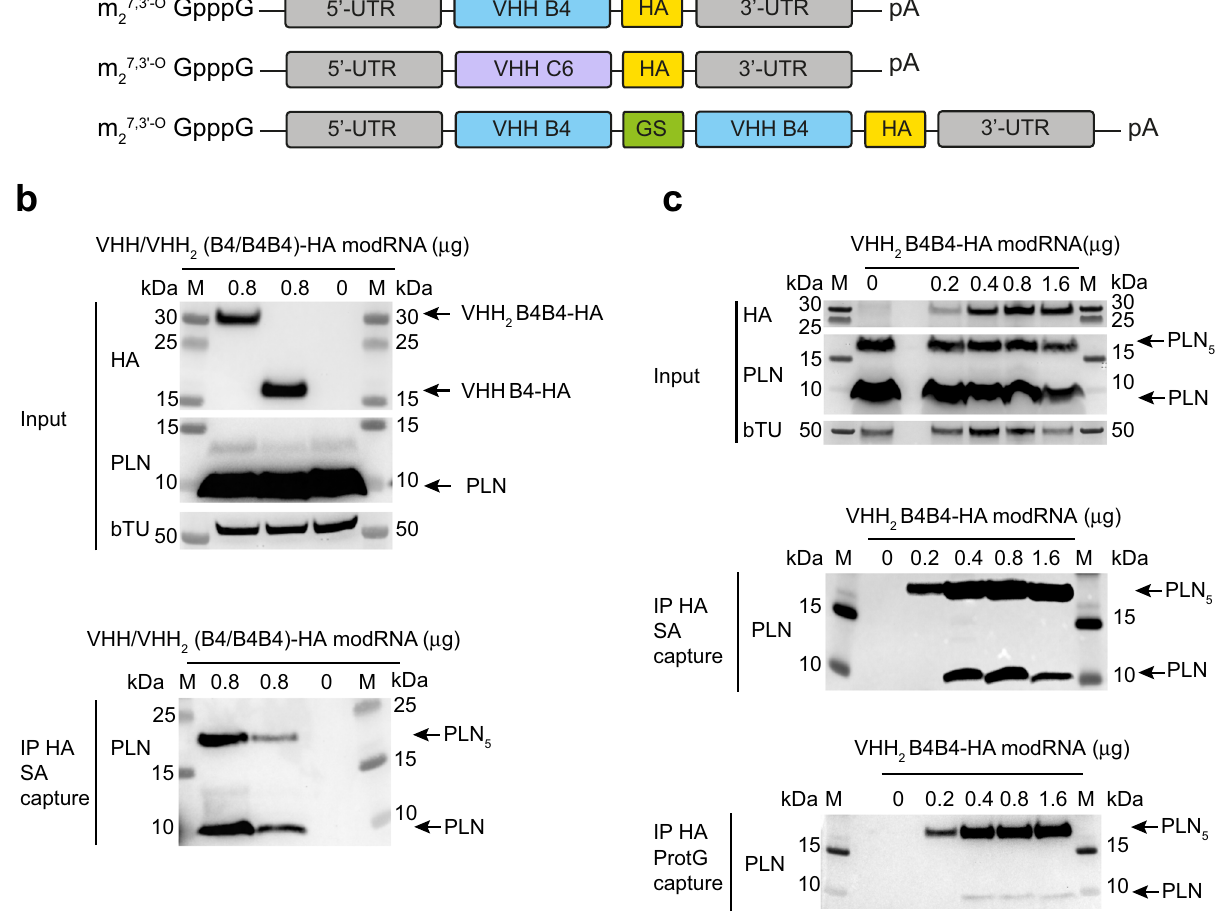
Fig. 2 Endogenous target engagement of intrabodies in rat neonatal cardiomyocytes using modRNA transfection. a modRNA construct design. m 2 7,3'-O GpppG is the ARCA CAP; 3 ’ UTR is the 3 ’ untranslated region, VHH is the intrabody sequence, GS is a sequence that encodes a glycine-serine linker peptide (GGGSGGGSGGGSGGGS), HA is the hemagglutinin tag, 5 ’ UTR is the 5 ’ untranslated region and pA is the poly-A tail. b Co-immunoprecipitation experiments using lysates of VHH B4-HA and VHH 2 B4B4-HA modRNA transfected rat neonatal cardiomyocytes. Molecular weight marker is indicated (M) and the sizes of the marker bands in kDa are noted at either side of the blot. Arrows and labels on the right indicate the size of different molecular species of PLN (PLN and PLN 5 ) or intrabody (VHH B4 and VHH 2 B4B4). Top panel: Western blots of cell lysates (boiled and reduced), probed with anti- HA, anti-PLN and anti- β -tubulin antibodies (left). Lower panel: Western blot of streptavidin magnetic bead-based co-IP using native elution and SDS-PAGE conditions and PLN detection. More than three independent Co-IP experiments successfully replicated the fi ndings. c Co-immunoprecipitation experiments using lysates of VHH 2 B4B4 modRNA transfected rat neonatal cardiomyocytes at different concentrations of modRNA. Molecular weight marker is indicated as M and sizes of the bands in kDa noted at either side of the blot. Arrows and labels indicate the size of different molecular species of PLN (PLN and PLN 5 ). Top panel: Western blots of input samples (non-boiled and non-reduced), with anti-HA, anti-PLN and anti- β -tubulin antibodies (left). Middle panel: Western blot of streptavidin magnetic bead-based co-IP using native elution and SDS-PAGE conditions and anti-PLN detection. Bottom panel: Western blot of protein-G magnetic bead-based co-IP using native elution and SDS-PAGE conditions and anti-PLN. This concentration-dependent co-IP experiment was not independently repeated. Source data are provided as a Source Data fi